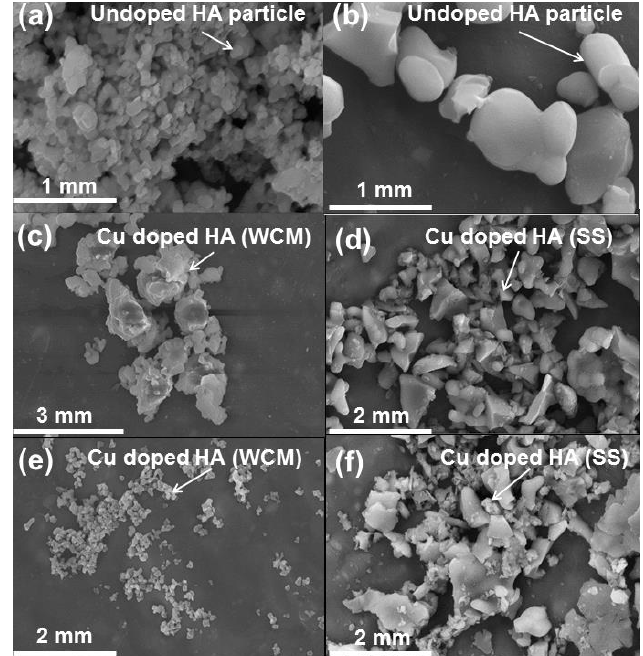
Figure 4. Field emission scanning electron microscopy (FESEM) images of HA and cupriferous HA Figure 4. Fieldemissionscanningelectronmicroscopy(FESEM)imagesofHAandcupriferousHAsystems, systems, including including ( a ) Ca 10 (PO 4 ) 6 (OH) 2 HAWCM, ( b ) Ca 10 (PO 4 ) 6 (OH) 2 HASS, ( c ) Ca 10 (PO 4 ) 6 [Cu 0.6 (OH) 0.8 O 0.6 ]